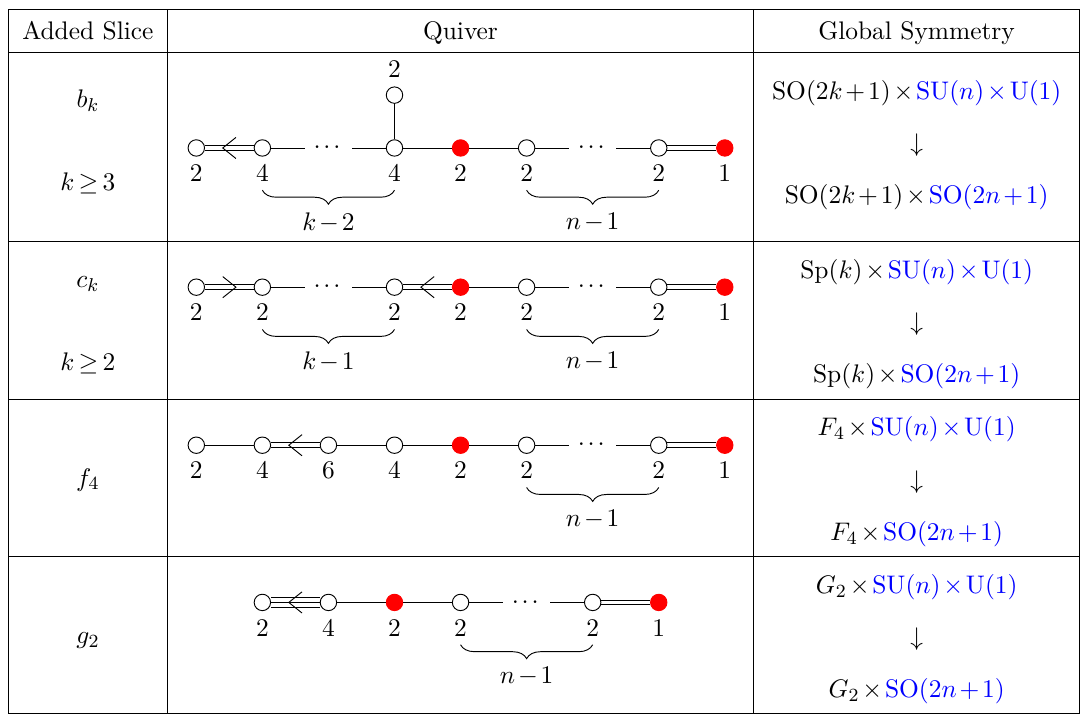
Table 11 . Quivers resulting from adding all possible non-simply laced elementary slice to the empty nodes of (4.9) to absorb a